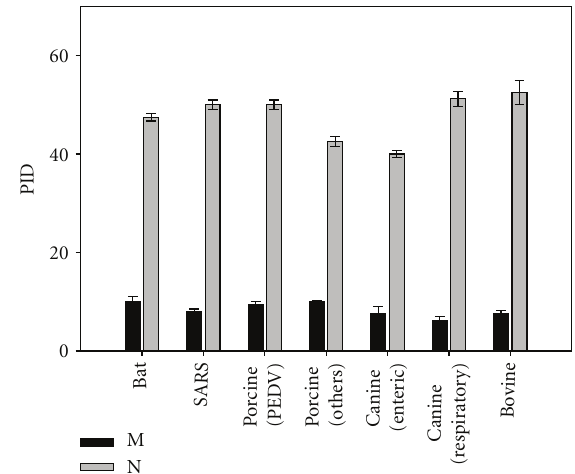
Figure 4: The mean PIDs of the M- and N-proteins of the various animal coronaviruses. Strains of porcine and canine coronaviruses are shown. Di ff erences are seen between the strains of porcine and canine